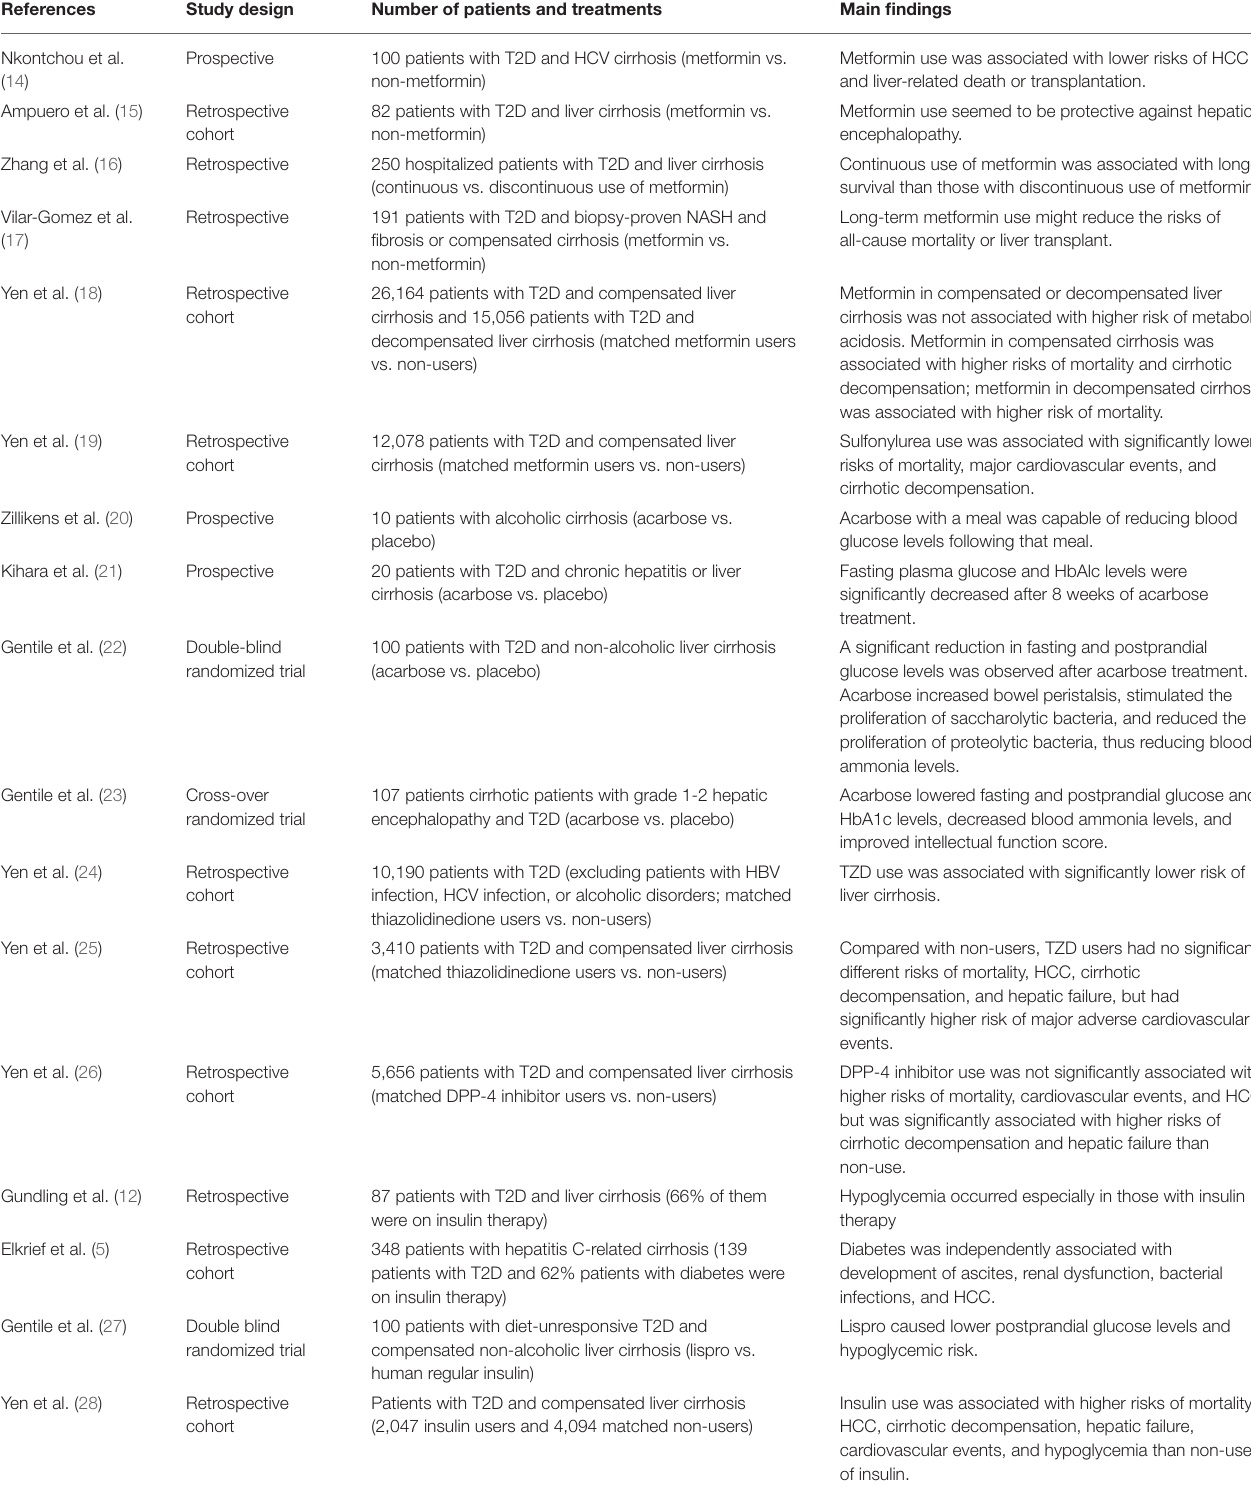
TABLE 1 | Studies evaluating the impact of antidiabetic medications in patients with type 2 diabetes and liver